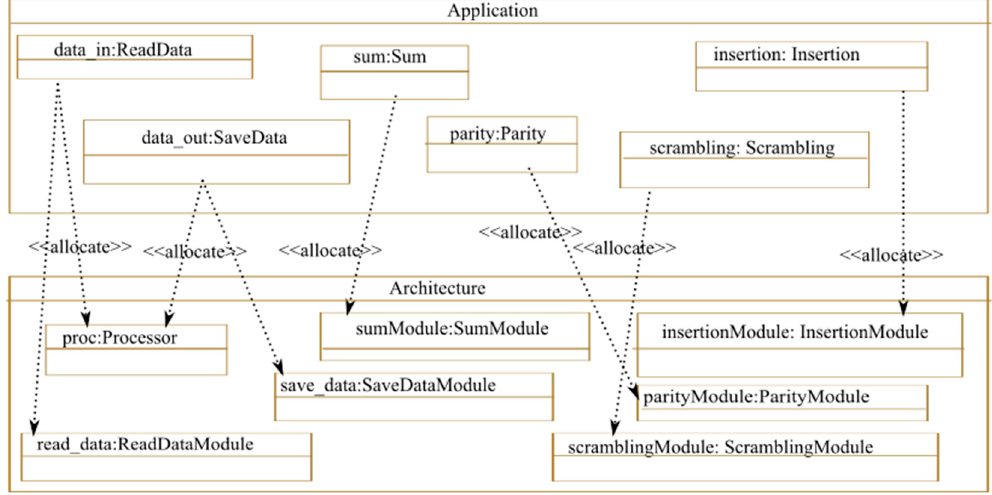
Figure 11. Static task allocation.